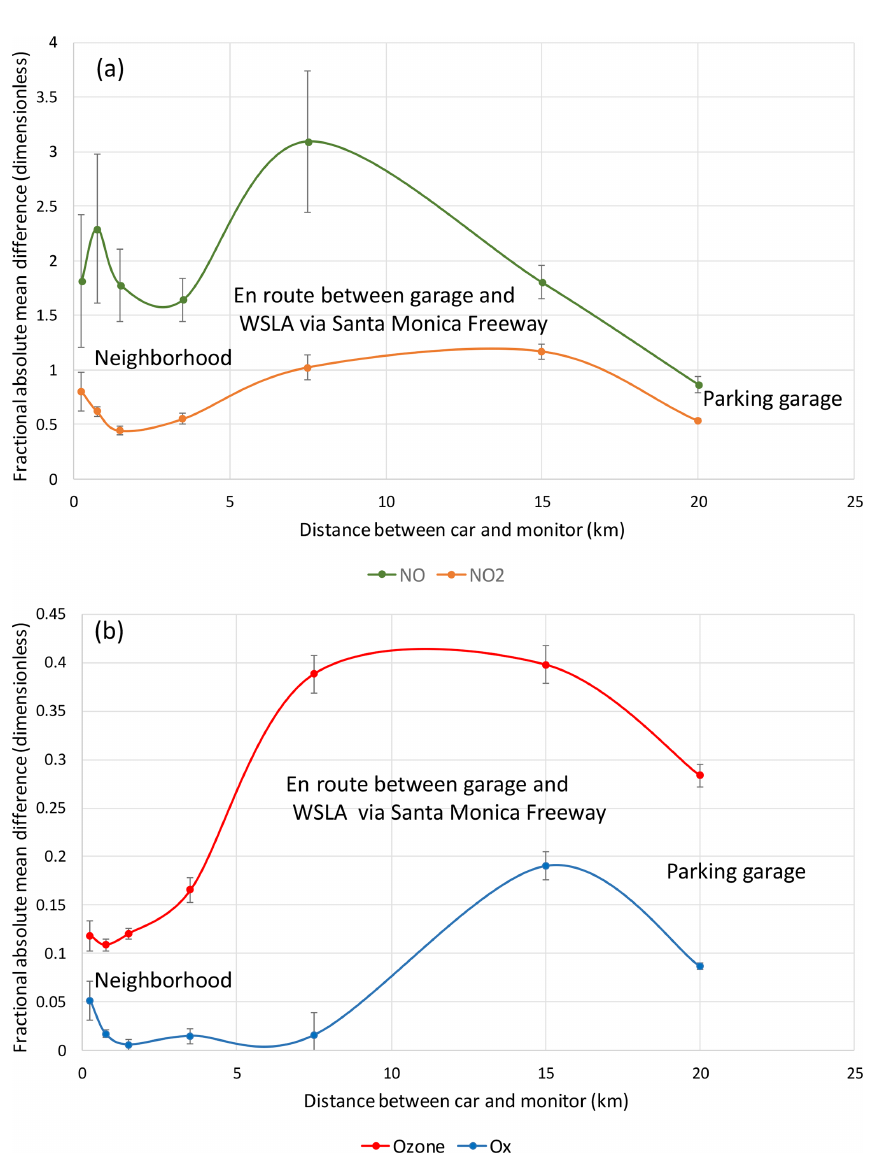
Figure 6. FAMD between mobile-platform monitoring and WSLA measurements versus distance between cars and WSLA on 4d (13, 19, 26, and 29 September 2016) when the cars drove near WSLA. The first bin includes all distances less than 0.5km; the minimum distance between cars and monitor was 158m. Locations are indicated. One-sigma uncertainties of the FAMD were determined as described in the definition of FAMD in the